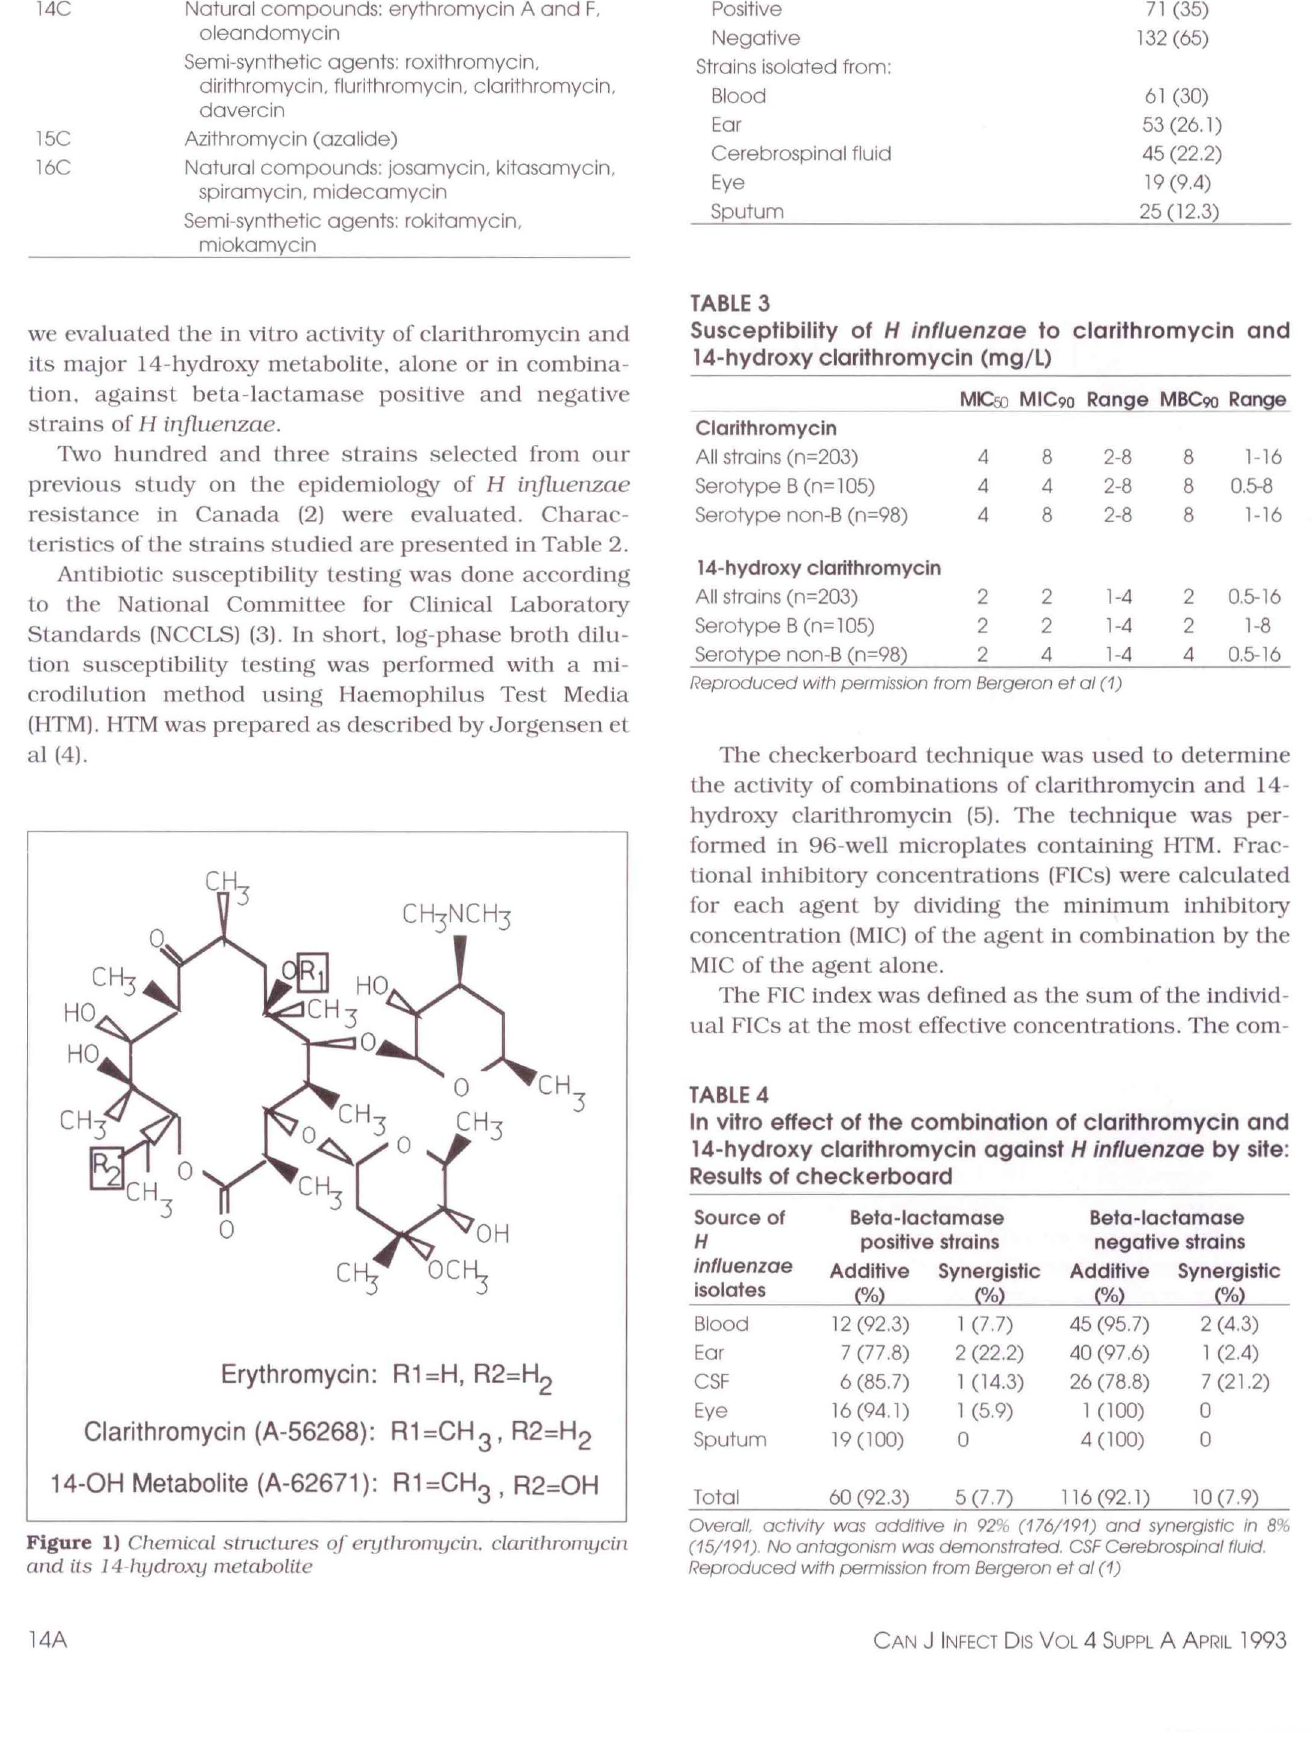
Summary of Haemophilus influenzae strains evaluated Beta-lactamase production status: